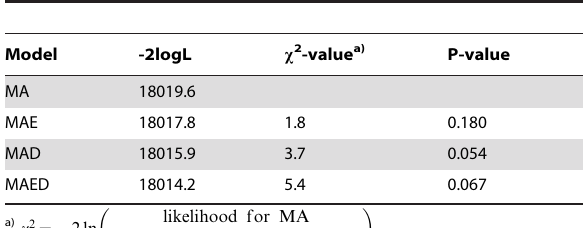
Table 3. -2log likelihood, x 2 value and the corresponding P- value of likelihood ratio.